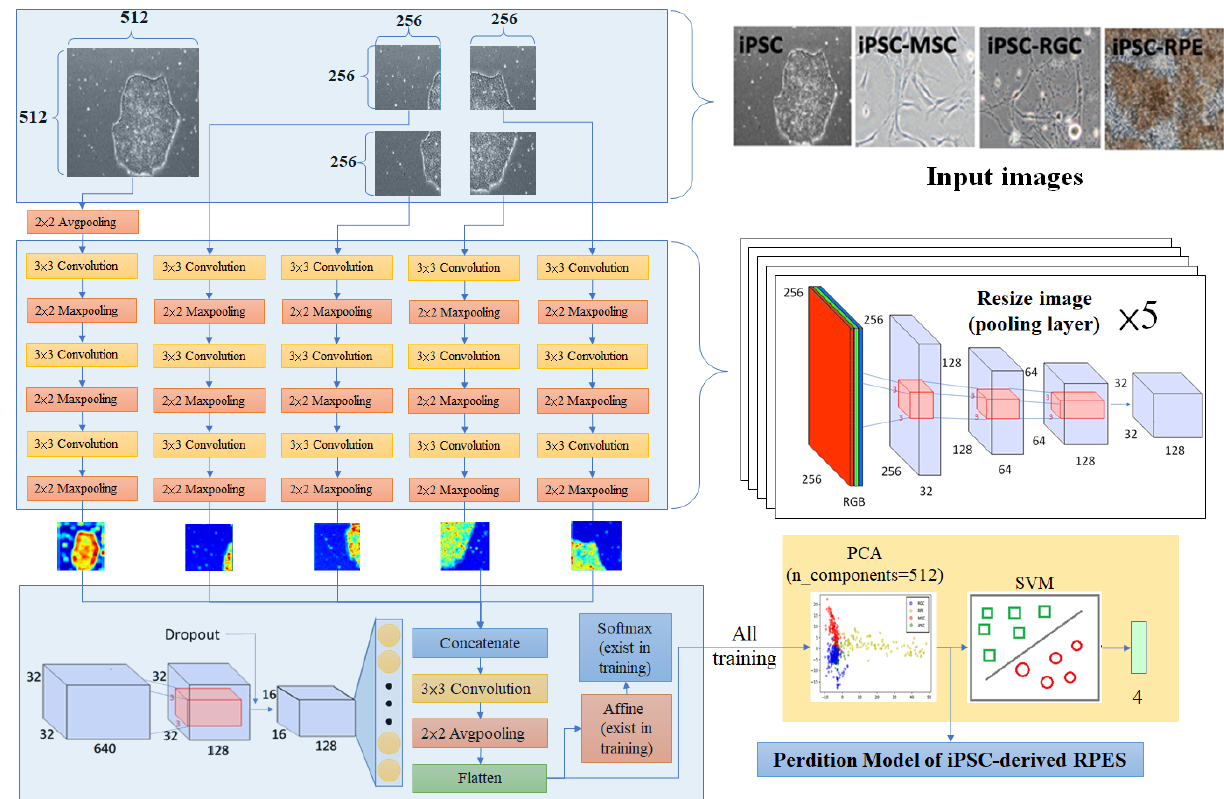
Figure 3. The CNN architecture of the proposed multi-slice tensor model.